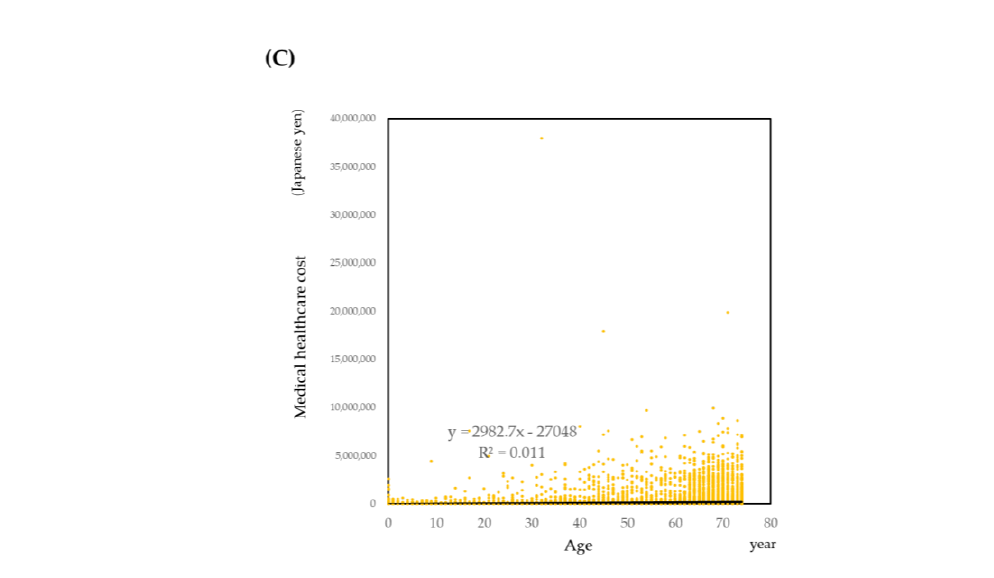
Figure 3. Scatter plot of medical healthcare cost against the medical healthcare cost of the previous year ( A ), dental healthcare cost of the previous year ( B ), and age ( C ). Plots were aggregated on the x or y axis.